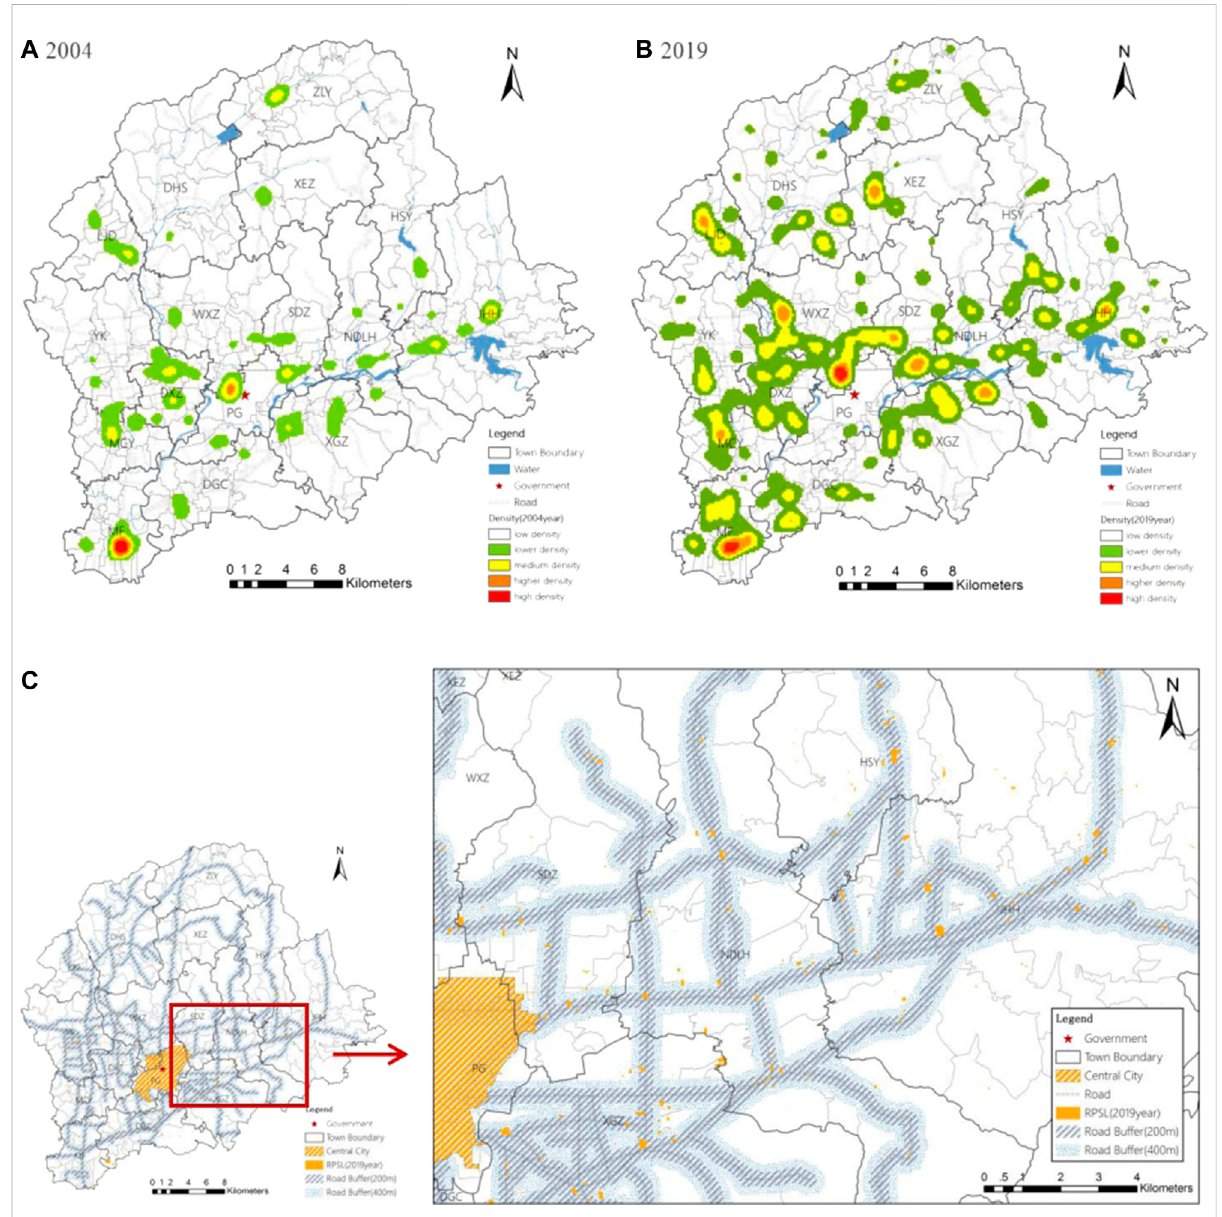
FIGURE 2 The spatial distribution of RPSL in